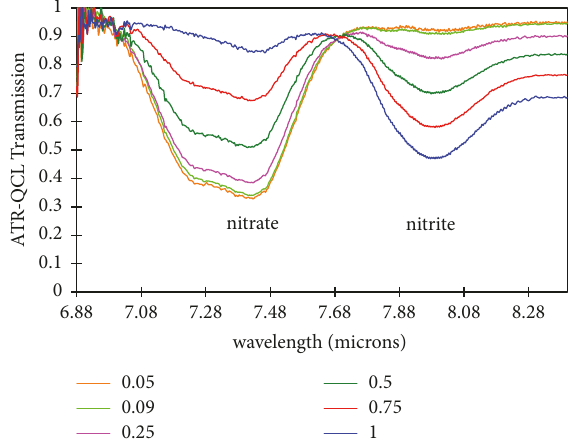
Figure 5: ATR-QCL transmission spectra of nitrite molar fraction rangeof0.05-1inpresenceofnitrate1Msolution.Theisobesticpoint at ∼ 7.7 𝜇 m is evident from the